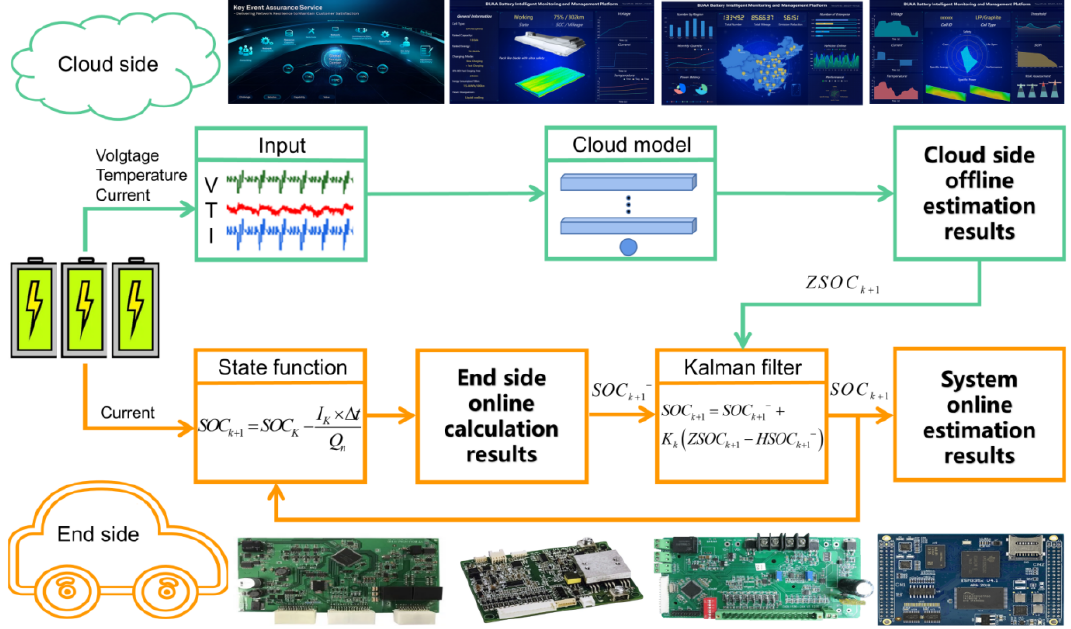
Figure 3. Framework of the proposed end ‐ cloud collaboration SOC estimation system based on CHAIN.